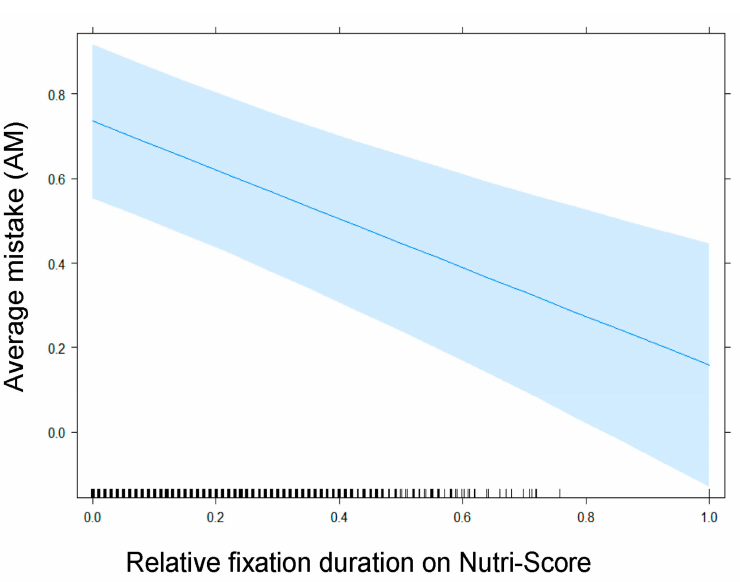
Figure 8. Impact of the relative fixation duration on Nutri-Score on AM in the subset of participants exposed to